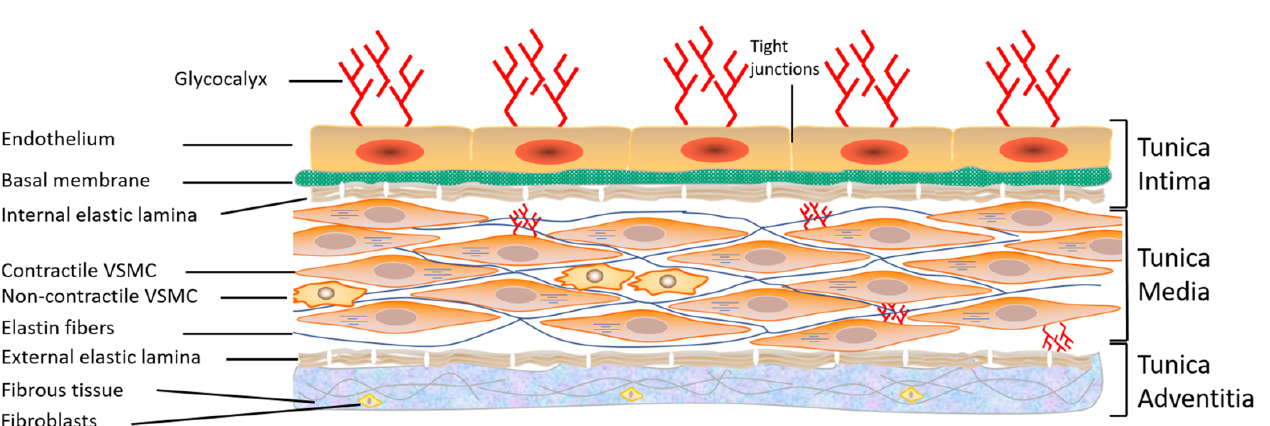
Figure 1. Structure of the vascular wall. Schematic representation showing the three layers of the vascular wall: tunica intima, tunica media, and tunica adventitia, as well as the components of each layer. VSMC: vascular smooth muscle cells (from Bkaily et al., 2021 [2]). The media is the thickest intermediate layer of the vascular wall. It consists of